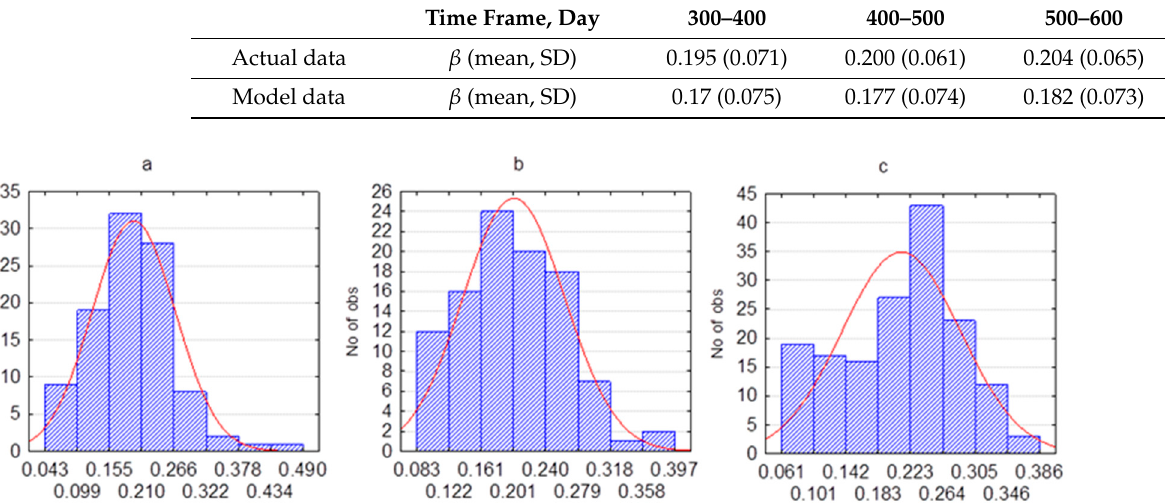
Figure 6. Transmission rate normality checking on the various testing time frames. ( a ) First test- ing time frame, 300–400 days (Shapiro–Wilk test, p = 0.00063). ( b ) Second testing time frame, 400–500 days (Shapiro–Wilk test, p = 0.049). ( c ) Third testing time frame, 500–600 days (Shapiro–Wilk test, p =